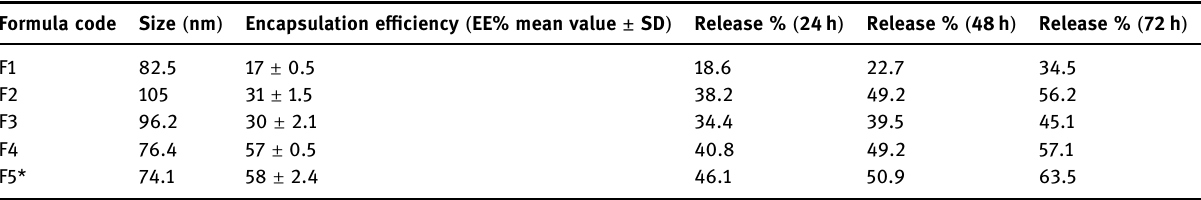
Table 5: Size, EE%, and extract release rate at 24, 48, and 72 h for Nio -